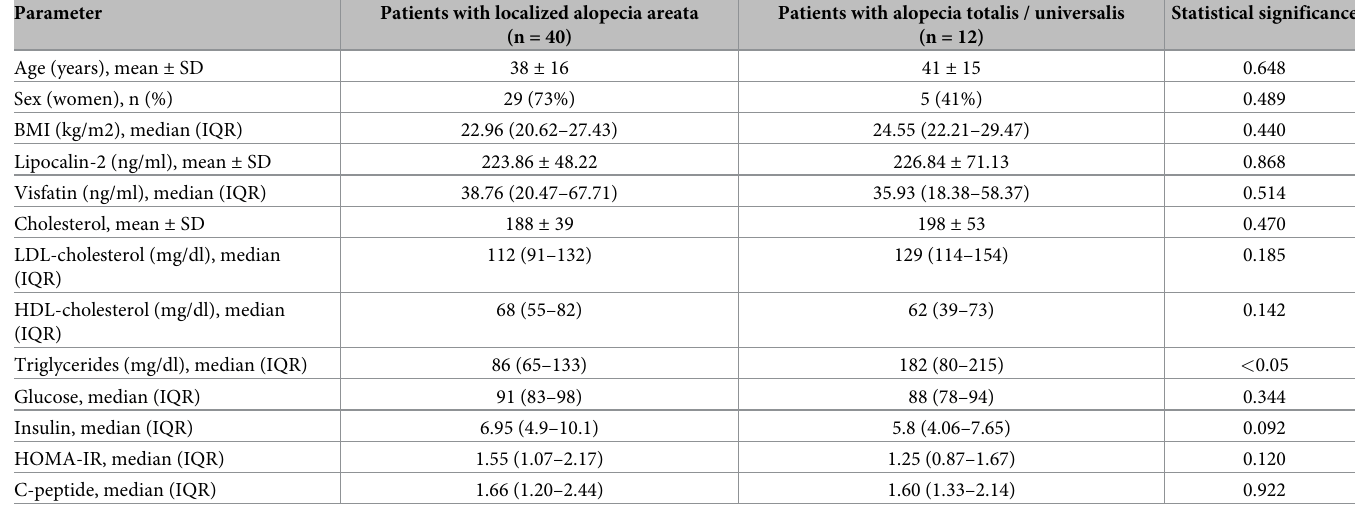
Table 4. Selected clinical and laboratory parameters in patients with localized alopecia areata and patients with alopecia totalis / universalis. Parameter